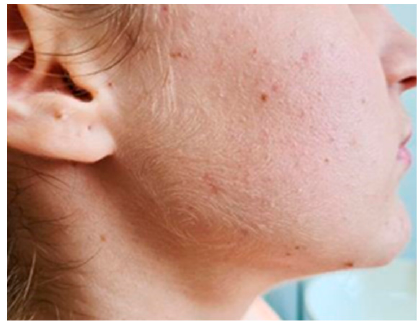
Figure 1. Submandibular pseudotumoral lesion.